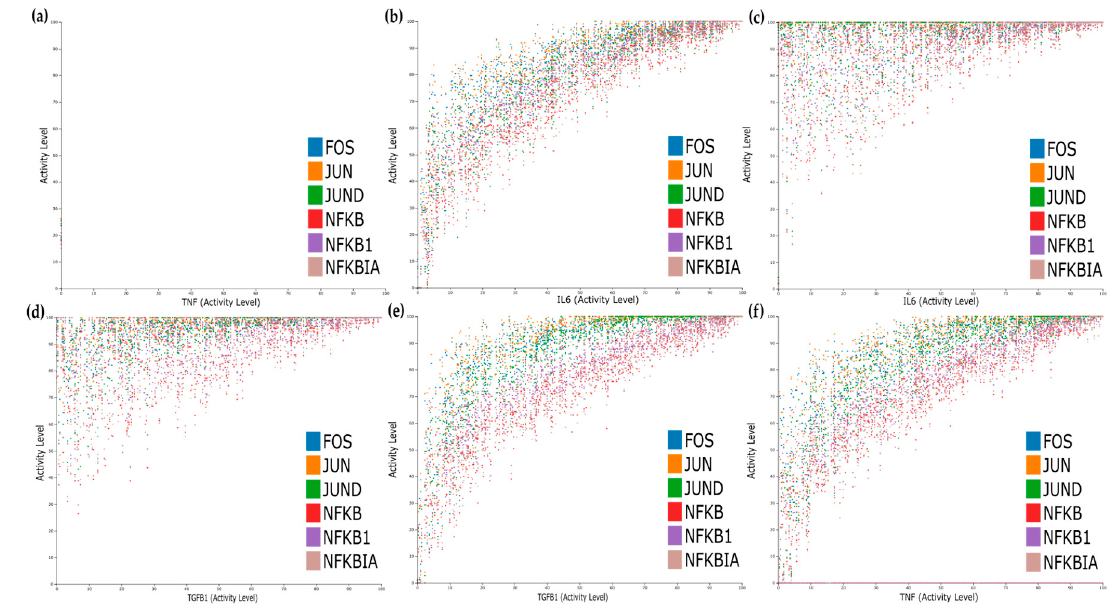
Figure 7. Dose–response analysis. ( a ) All inputs inactive. ( b ) IL6 active. ( c ) IL6 and TGFB1 active (TGFB1 view). ( d ) IL6 and TGFB1 active (IL6 view). ( e ) TGFB1 active. ( f ) TNF active.